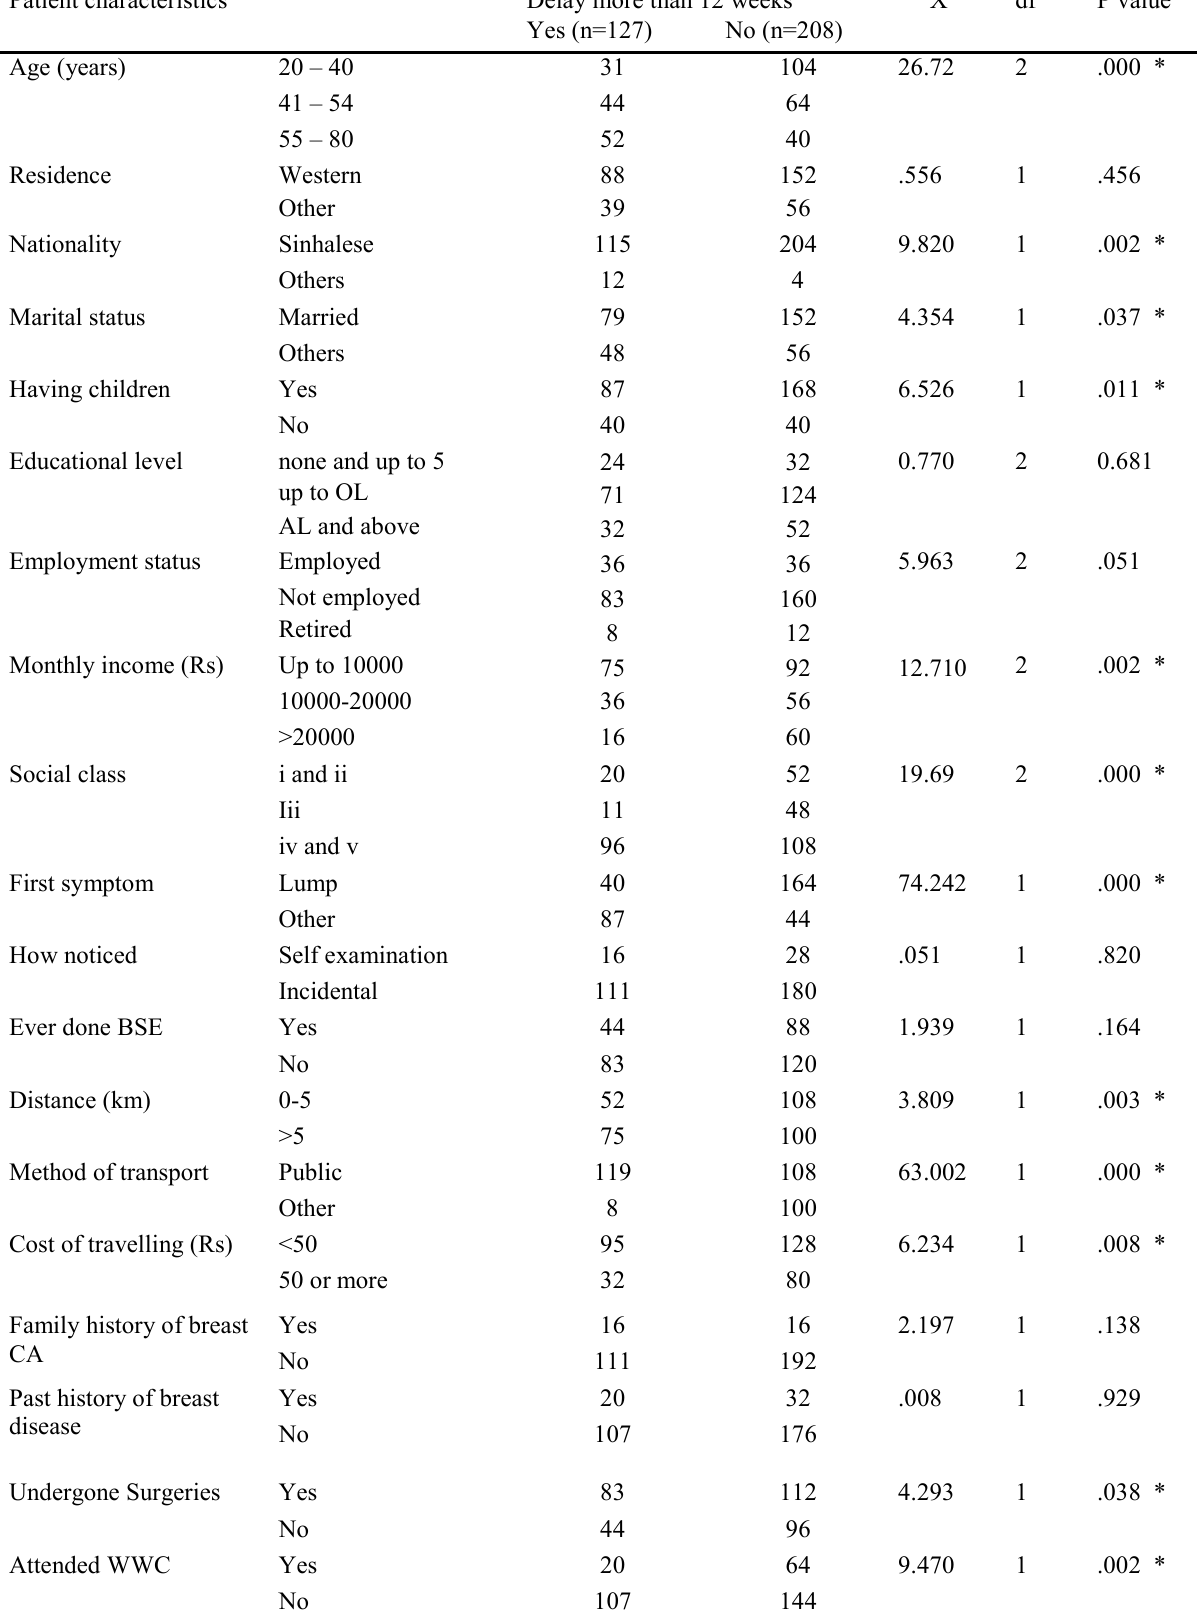
Table 2: Distribution of delay in seeking allopathic treatment by patient characteristics Patient